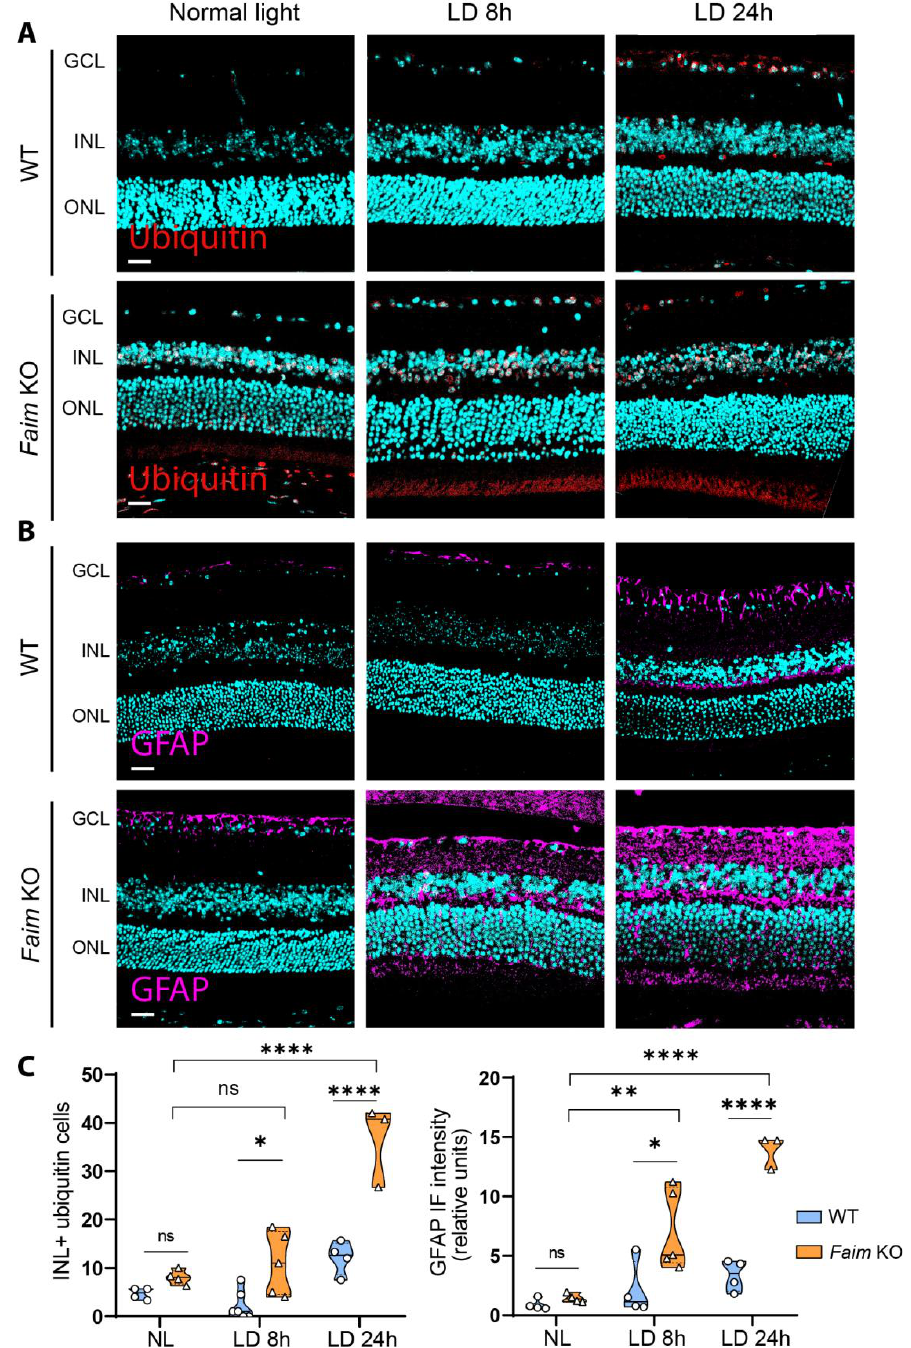
Figure 9. Faim KO retinas are more prone to accumulate ubiquitin aggregates and express more GFAP than WT mice after light damage. Representative images of 4 µ m paraffin sections of retinas taken from three-month-old mice exposed to normal light and to light damage for 8 h (LD 8 h) or 24 h (LD 24 h) and immunolabeled for ( A ) ubiquitin (red) or ( B ) GFAP (magenta). Nuclei were stained with Hoechst (cyan). ( C ) Ubiquitin-positive cells in the INL were counted in at least five images per mice (left); total GFAP intensity was quantified using ImageJ software in at least five images per mice (right). Data are plotted as violin plots. Each plot extends from the min to max values and the median is represented by a thick dashed line ( n = 4–6 mice/group). Statistical analysis was performed using Two-way ANOVA and Sidak’s post-hoc test; * p < 0.05, ** p < 0.01, **** p < 0.001. GCL: ganglion cell layer; INL: inner nuclear layer; ONL: outer nuclear layer. Scale bar: 20 µ